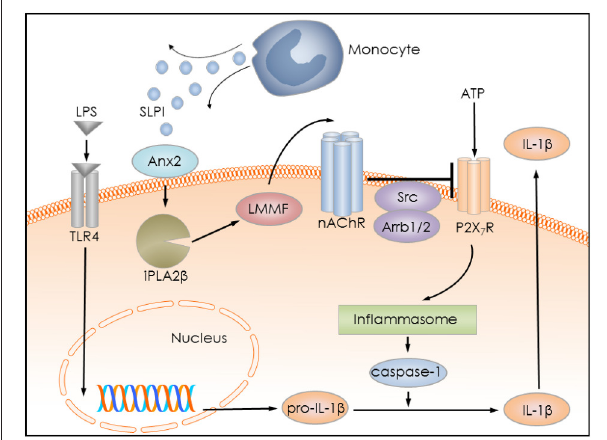
FIGURE 14 | Graphical representation of the proposed inhibitory mechanism mediated by SLPI. LPS stimulates Toll-like receptor 4 (TLR4) at monocytic cells and induces the synthesis of pro-IL-1 β . Extracellular ATP activates the P2X 7 R and leads to inflammasome assembly, caspase-1 activation and proteolytic cleavage of pro-IL-1 β , and release of mature IL-1 β . SLPI released for example from monocytes, activates iPLA2 β in an annexin 2 (Anx2)-dependent manner and induces the production and release of an inhibitory low molecular mass factor (LMMF) that functions as an agonist of nicotinic acetylcholine receptors (nAChR). The LLMF in turn activates nACHRs containing subunits α 7, α 9, and α 10, resulting in Src kinase activation, inhibition of P2X 7 R function, prevention of pro-IL-1 β maturation, and IL-1 β